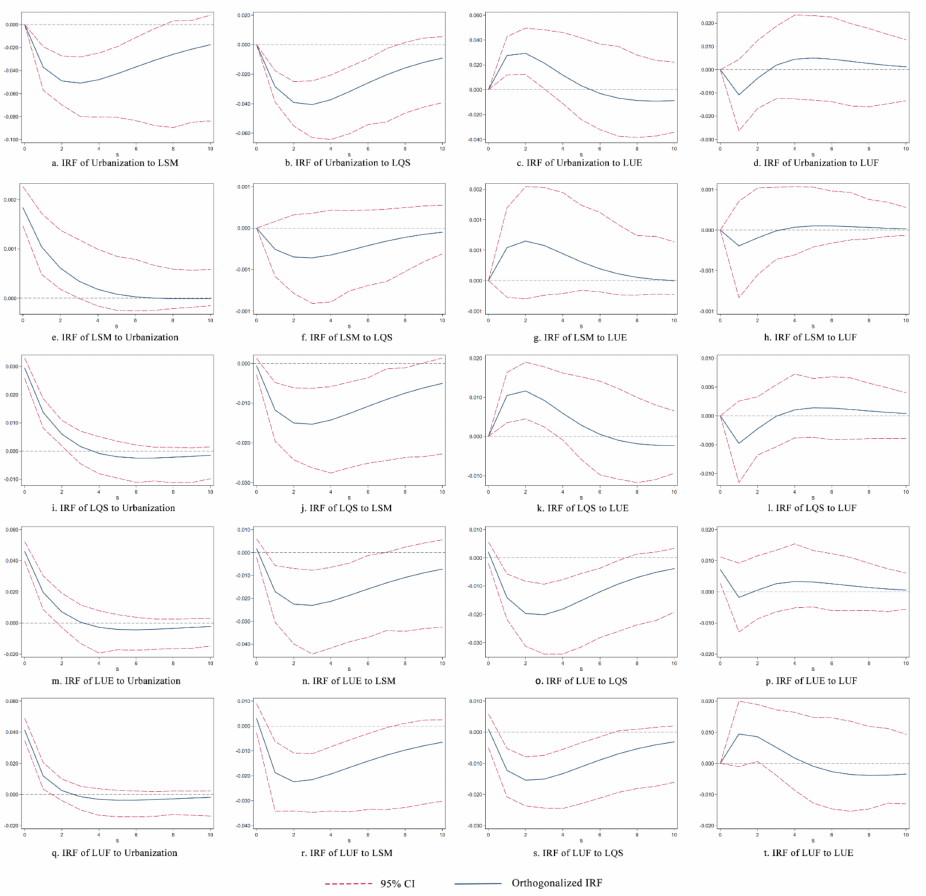
Figure 4. Pulse response results of Model